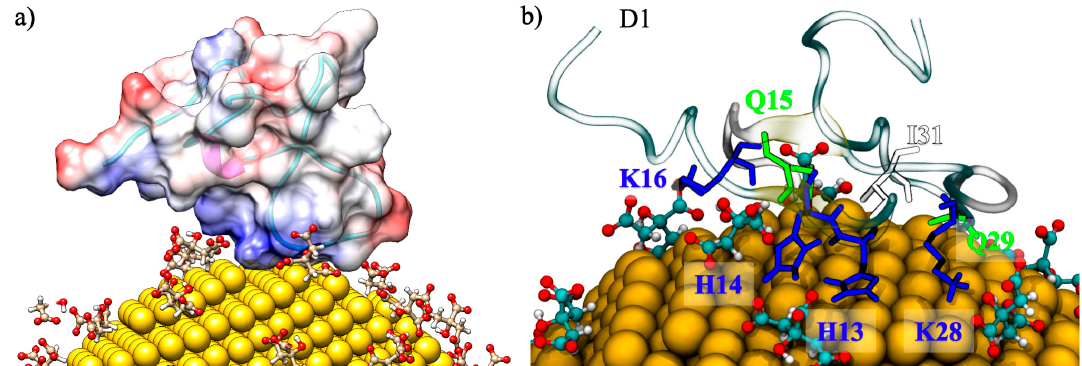
Figure 2. Representative snapshots of A β -peptides interacting with the citrate-capped AuNP; the results for the 1:1 A β (1–40)/AuNP concentration ratio are shown. In panel ( a ), the A β is rendered as a surface colored accordingly to its coulombic potential; negatively charged residues are colored in red, and positively charged residues are shown in blue. In panel ( b ), the interaction driven by positively charged amino acids is shown in blue.